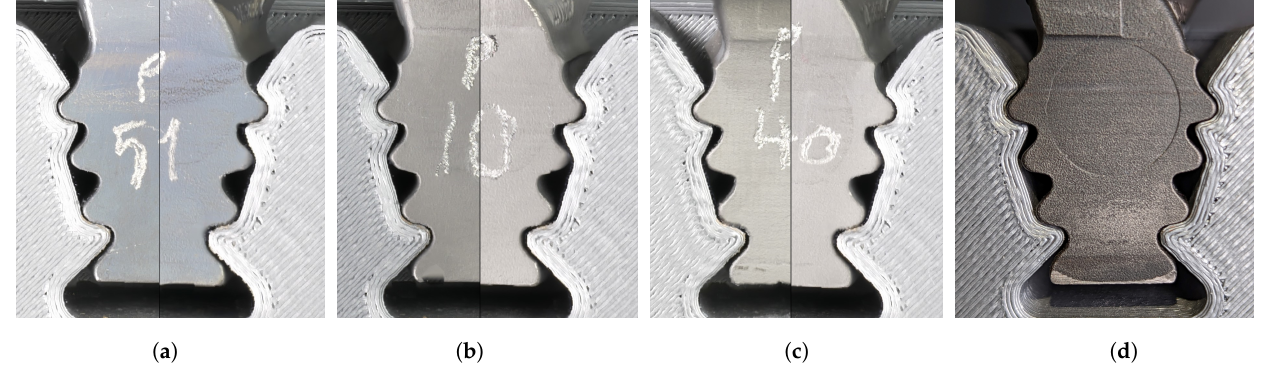
Figure A1. Additional load test with partly visual changes due to load exertion on the blade root.